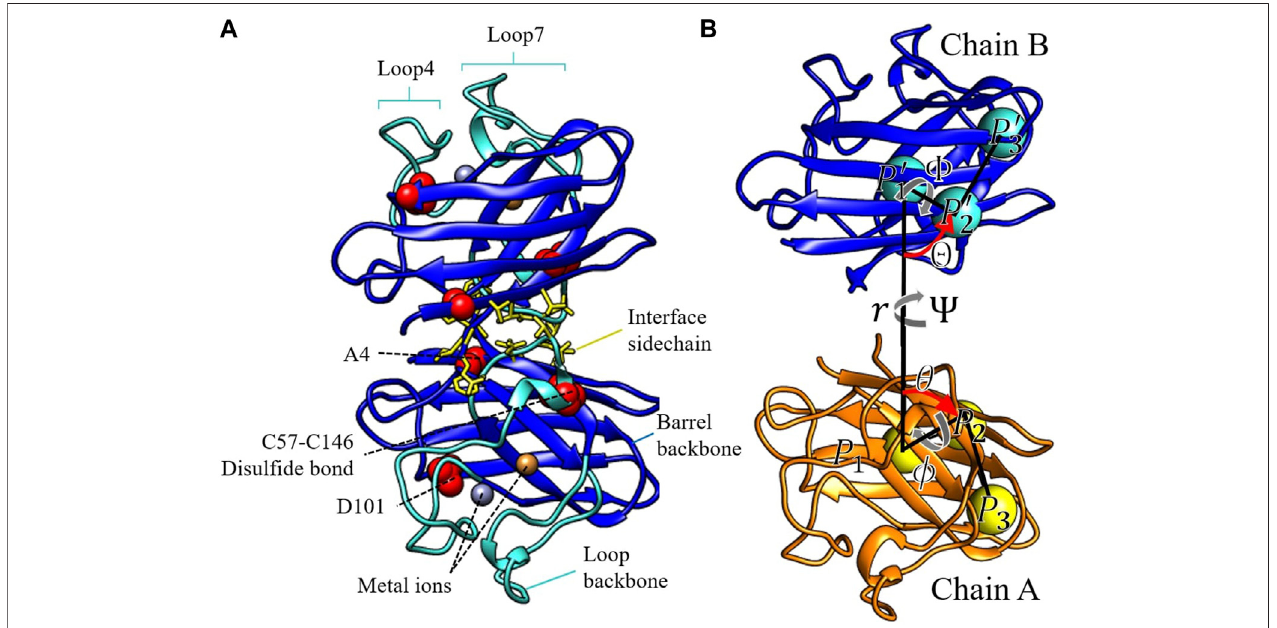
FIGURE 1 | (A) The three components of the conformational restraints displayed in color, for the SOD1 homodimer. The central barrel backbone is in blue. The backbones of the large fl exible loops 4 and 7 are in turquoise. The side chains of the dimer interface residue are in yellow licorice. The structural elements altered in this study are labeled in panel (A) and rendered in red van der Waals spheres. (B) Representation of the local reference frame of WT E,E (SS) used to de fi ne chain B position and orientation relative to chain A (see text for a description).